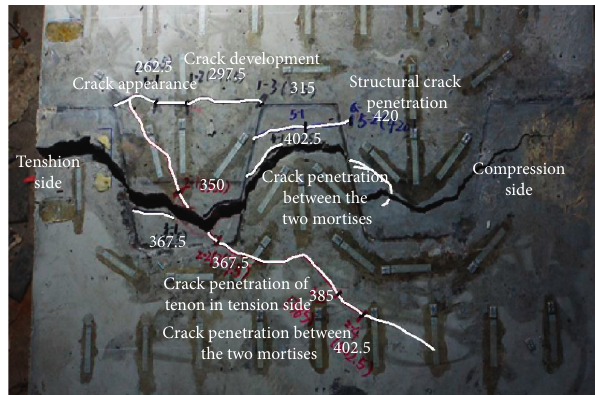
Figure 12: Failure modes of specimen under axial force 500kN.